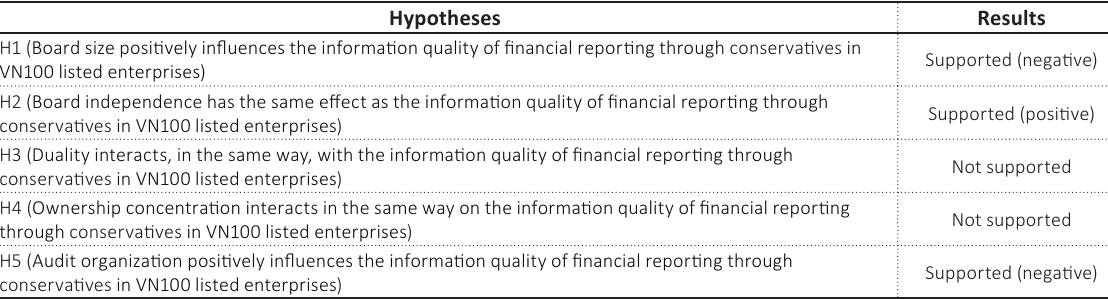
Table 5. Results of